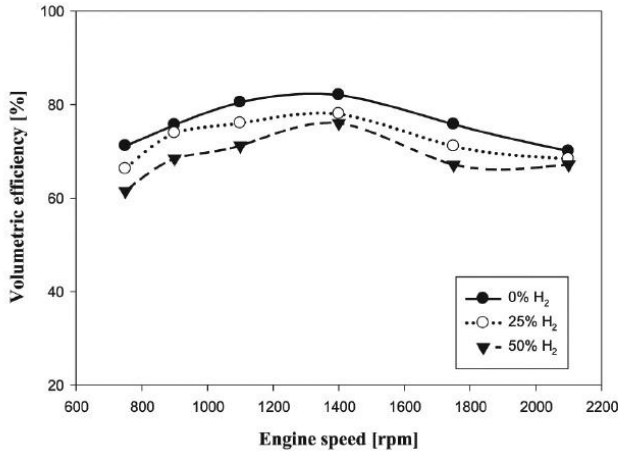
Figure 6. Volumetric efficiency changes with different percentages of hydrogen in the CI engine [78].